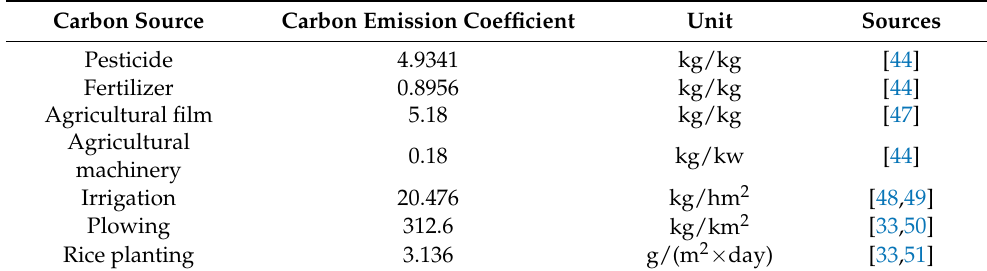
Table 2. Emission coefficients of major carbon